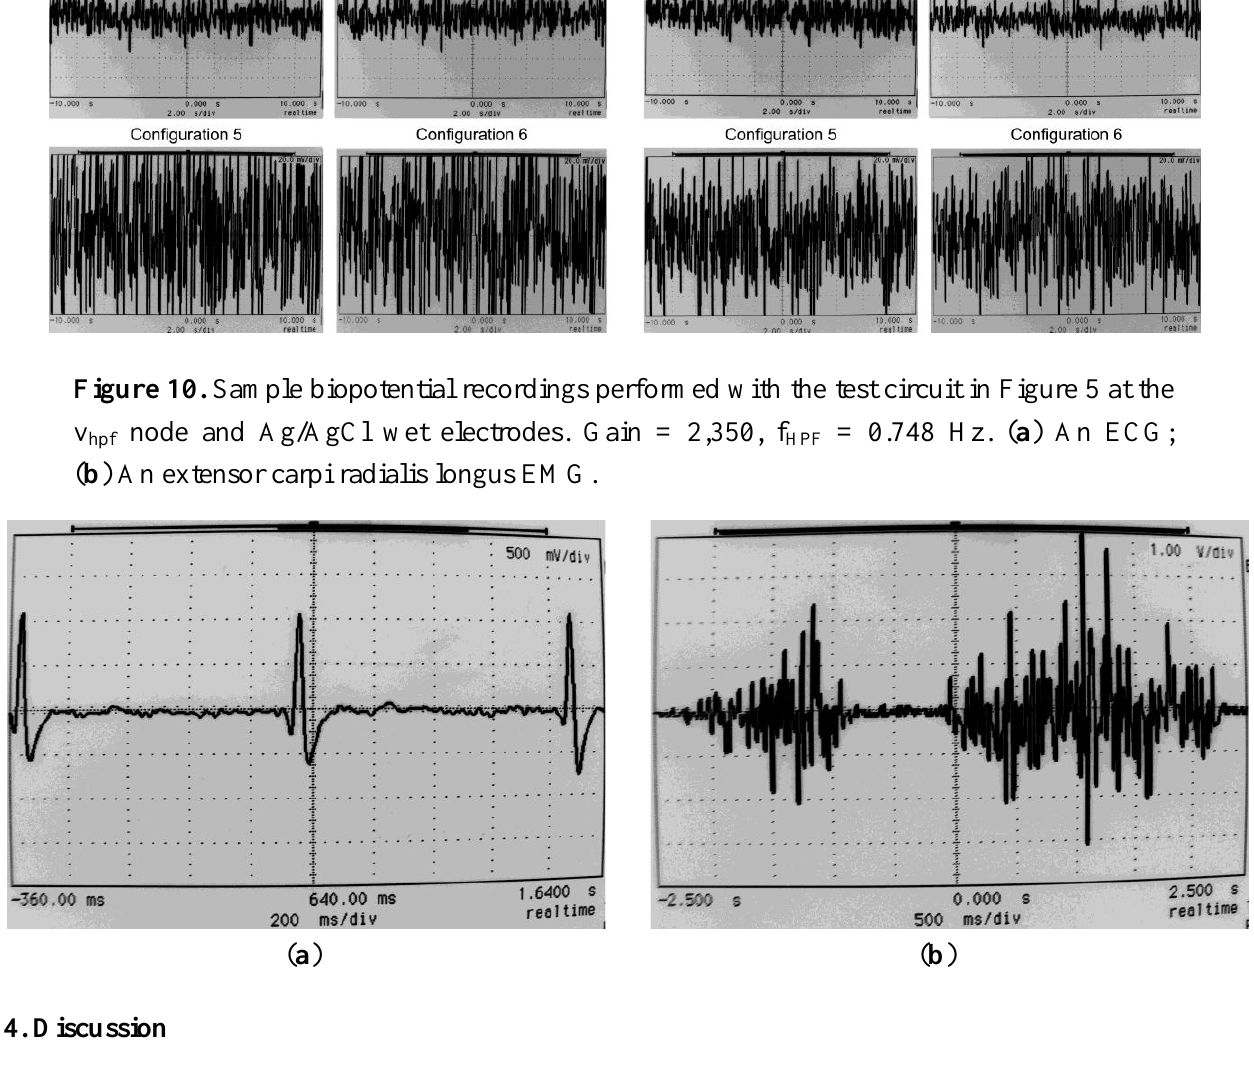
and the MAX44252 as the HPF o